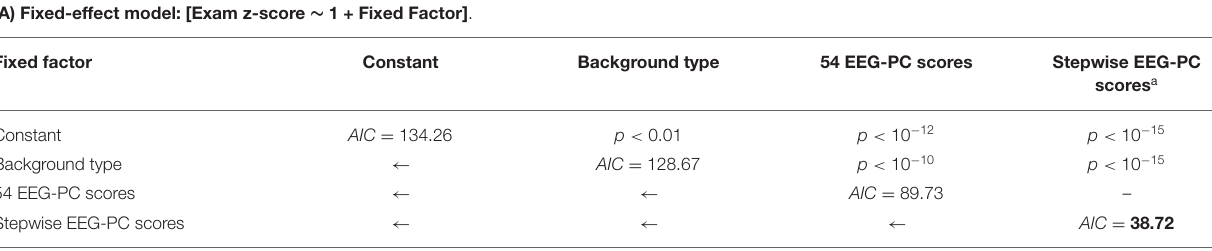
TABLE 4 | Predictability of exam z-scores using (A) fixed-effect and (B) mixed-effect